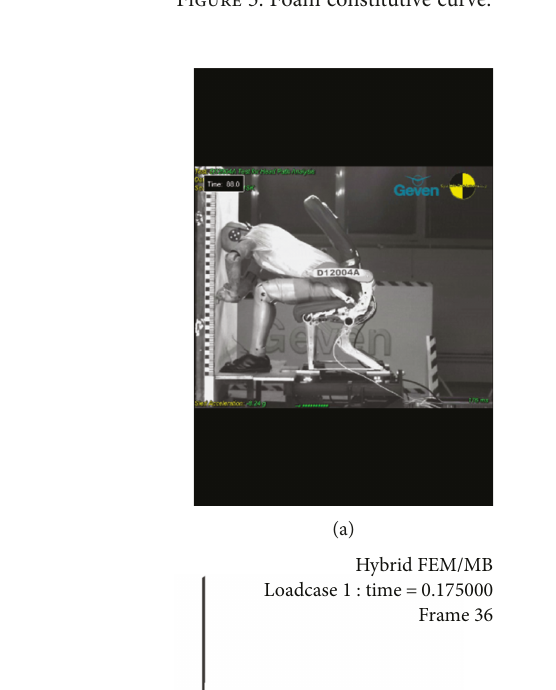
Figure 5: Foam constitutive curve.